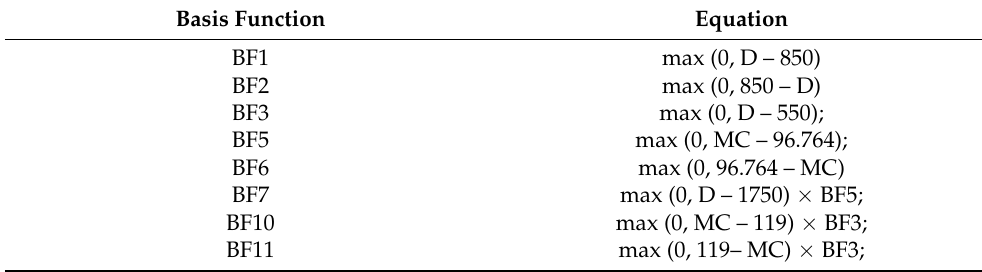
Table 9. The Relationship Between Basis Functions and their Related